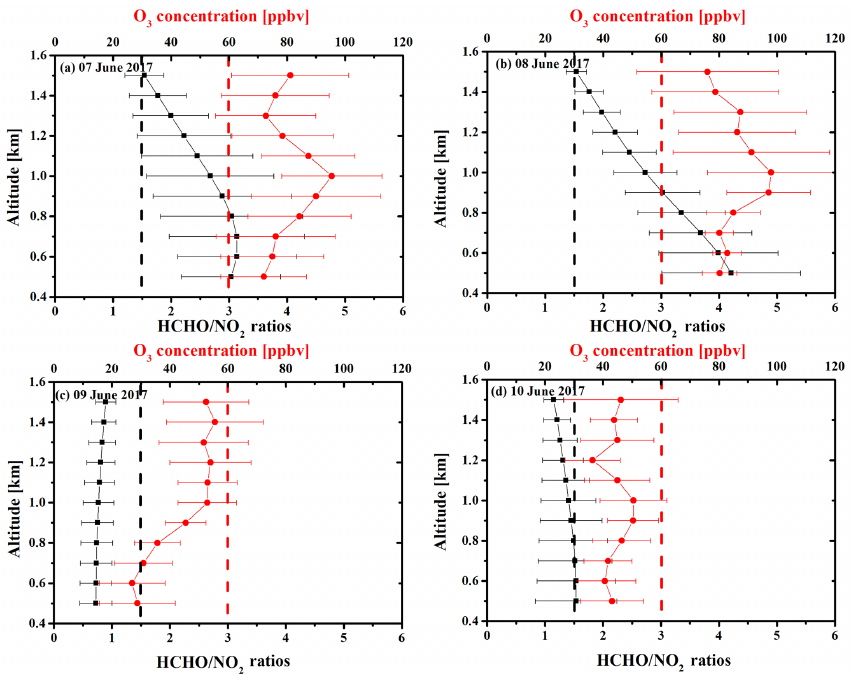
Figure 14. The daily averaged vertical profiles of O 3 concentrations and HCHO / NO 2 ratios at different altitudes between 09:00 and 15:00LT on 7 to 10 June